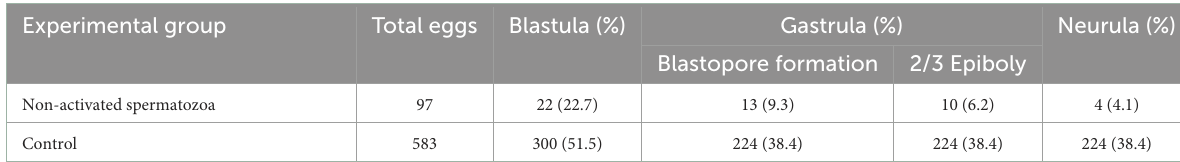
Blastopore formation